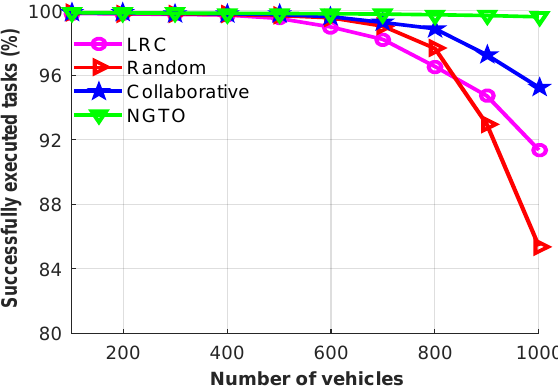
Figure 6. Successfully executed tasks for various numbers of vehicles.